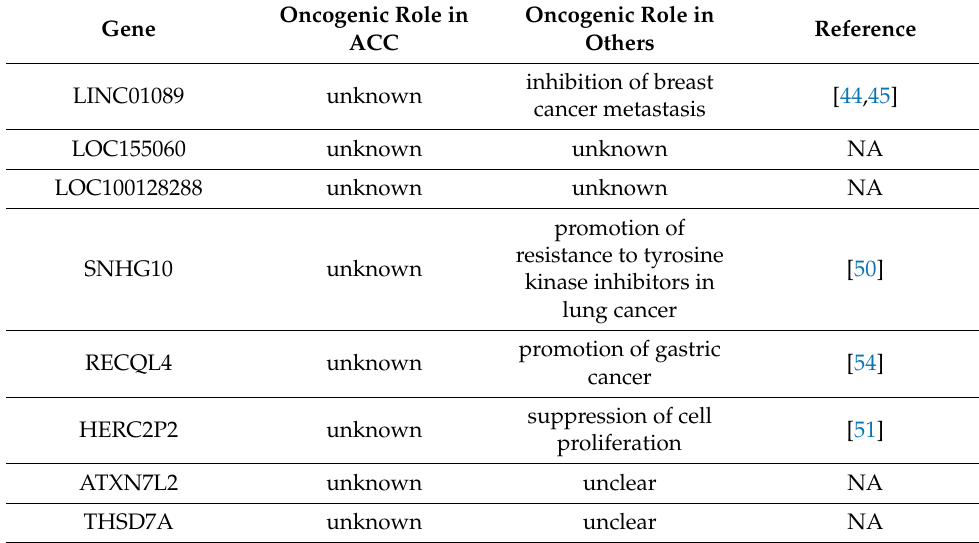
Table 3. Oncogenic role of the SigIQvar8 component genes. Oncogenic Role in Oncogenic Role in Gene ACC Others